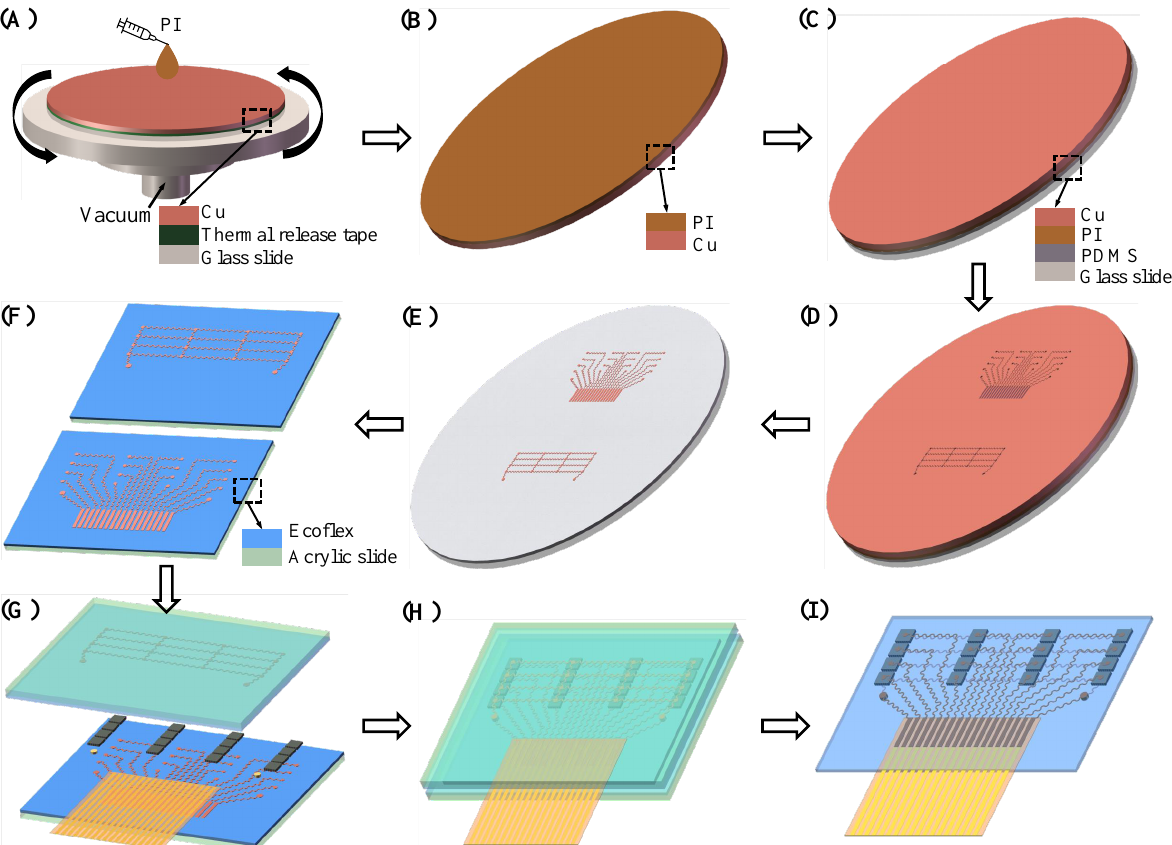
Figure 3. Fabrication process of a flexible ultrasound array ( A ) Spin-coating PI. ( B ) Heat to cure PI and remove the thermal release tape. ( C ) Laminate the PI layer of Cu–PI in contact with the PDMS. ( D ) Stretchable electrodes patterning using the laser. ( E ) The electrode pattern is retained after the excess Cu–PI layer is peeled off. ( F ) The electrode is transferred to the acrylic slide spin-coated with Ecoflex. ( G ) Integration. ( H ) Encapsulated with Ecoflex. ( I ) Acrylic slide